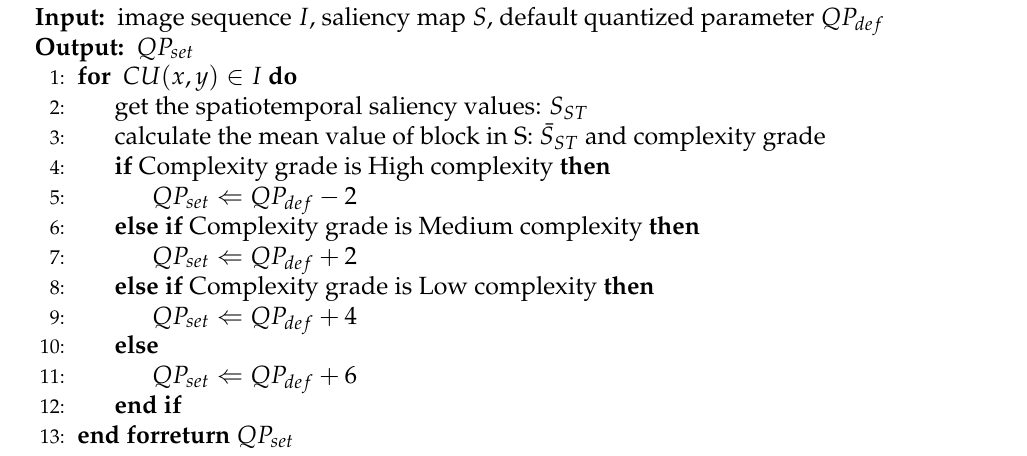
Algorithm 1 Saliency-based quantization control